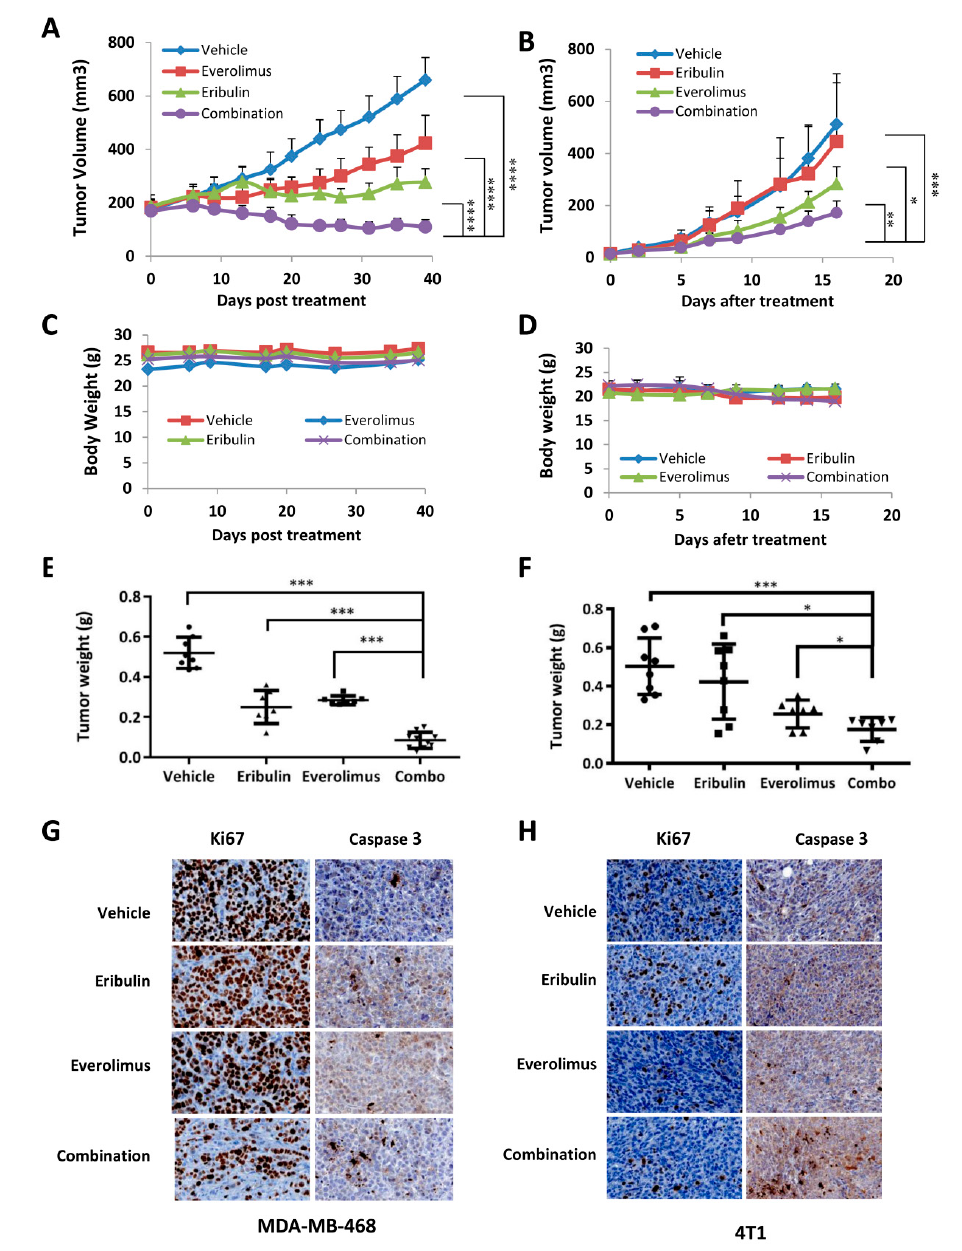
Figure 6. Combined treatment of eribulin and everolimus enhances anti-tumor activity in mice. MDA-MB-468 ( A , C , E , G ) and 4T1 ( B , D , F , H ) were implanted into the mammary fat pad of NOD / SCID / IL2Rgamma null (NSG) mice and BALB / c mice, respectively. NSG mice with MDA-MB-468 tumors were treated with a vehicle, eribulin (0.2 mg / kg for the first week, 0.1 mg / kg for the remainder of the treatment period, via retro-orbital), everolimus (5 mg / kg via oral gavage), or their combination two times a week. BALB / c mice with 4T1 tumors were treated with a vehicle, eribulin (1 mg / kg via retro-orbital), everolimus (5 mg / kg via oral gavage), or their combination three times a week. Tumor growth ( A , B ) and body weight ( C , D ) were measured once to twice a week. ( E , F ) Tumor weight was measured at end of the treatment ( G , H ) Shown are representative images of Ki67 and cleaved-caspase 3 immunohistochemstry in MDA-MB-468 and 4T1 tumor tissues. Data represents means ± SD (n = 7–10). *, p < 0.05; **, p < 0.005. ***, p < 0.0005, ****, p <